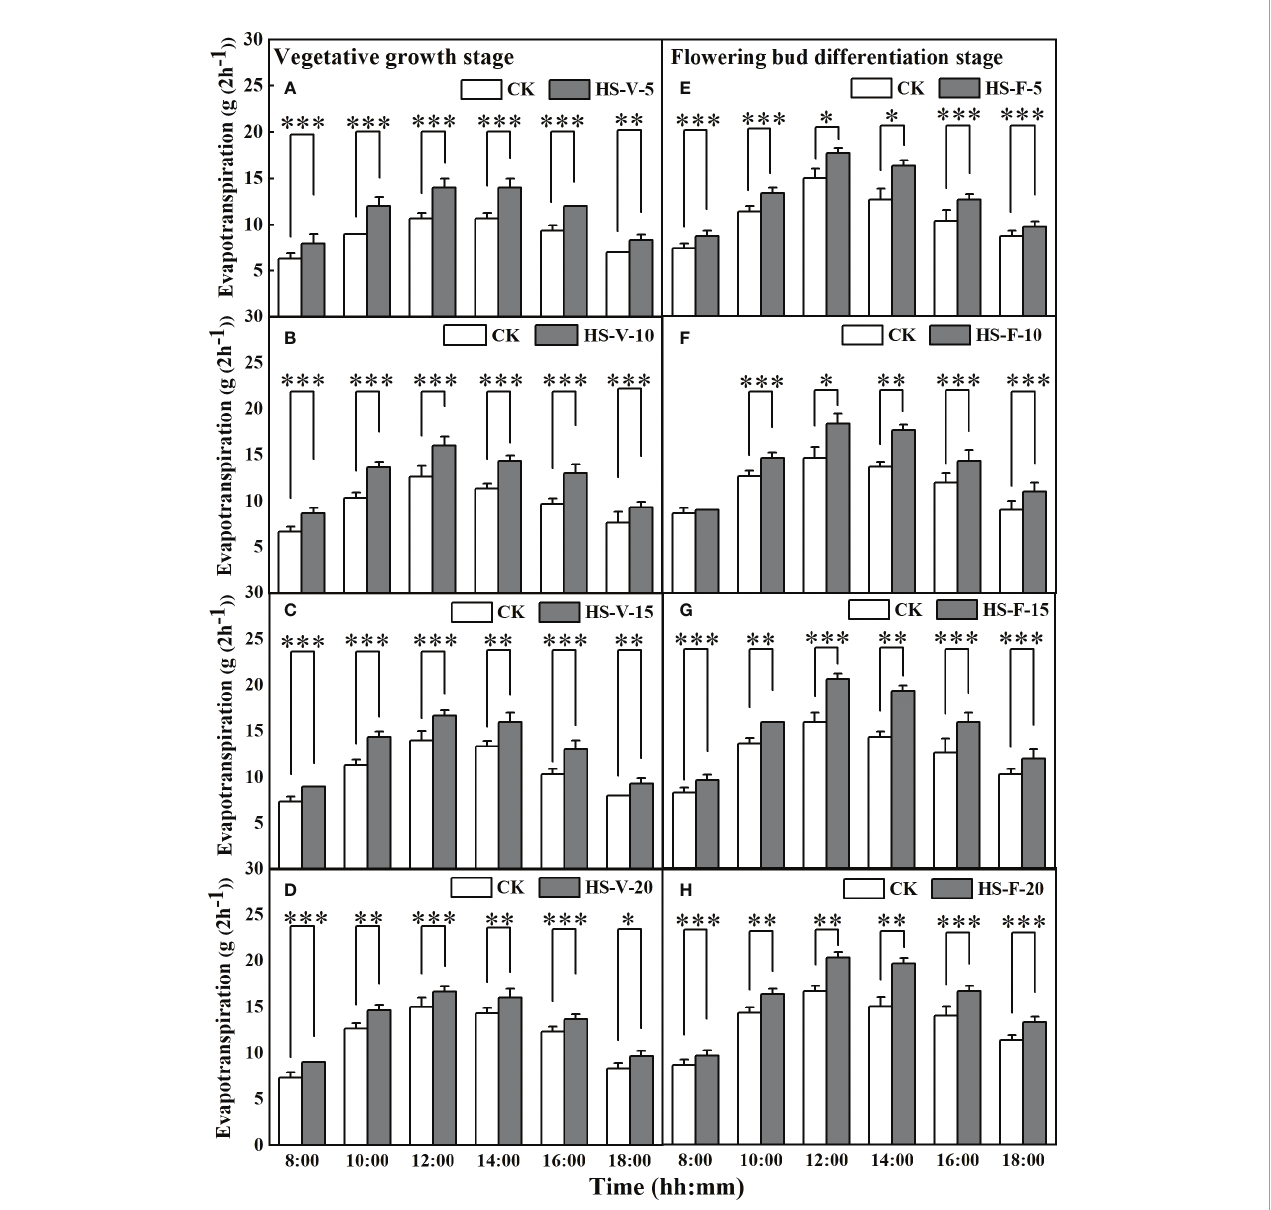
FIGURE 7 Diurnal variation of evapotranspiration under different temperature treatments during the vegetative growth (A – D) and fl owering bud differentiation stages (E – H) . *, **, and *** represent the signi fi cant level at P <0.05, P <0.01, and P <0.001, respectively. The error bars represent standard deviation